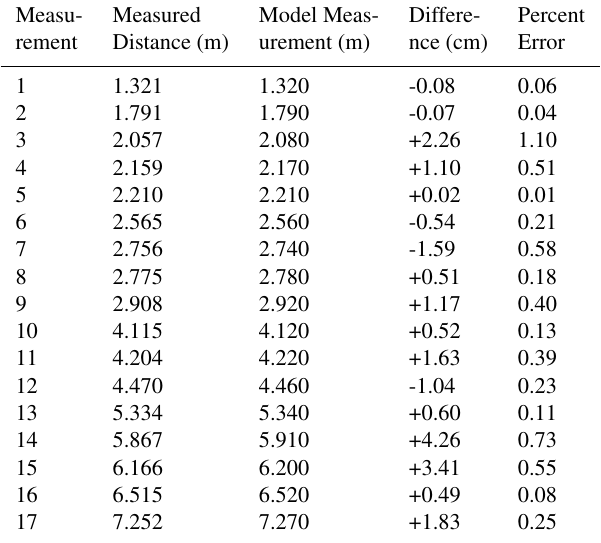
Table 2: Measurements from Phoenix Rock Gym and corre- sponding measurements from the resulting model Camelback mountain near the Arizona State University. Many